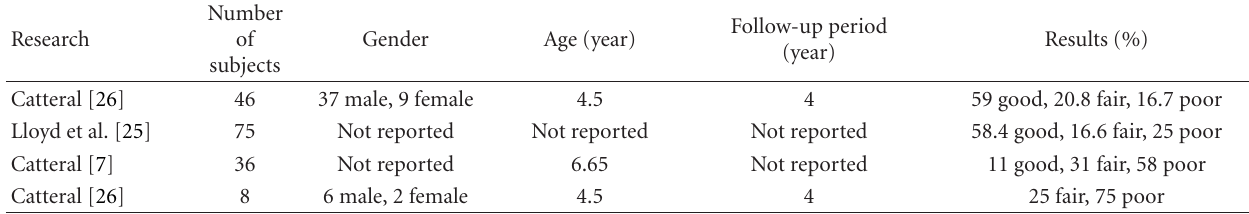
Table 7: The results of conservative